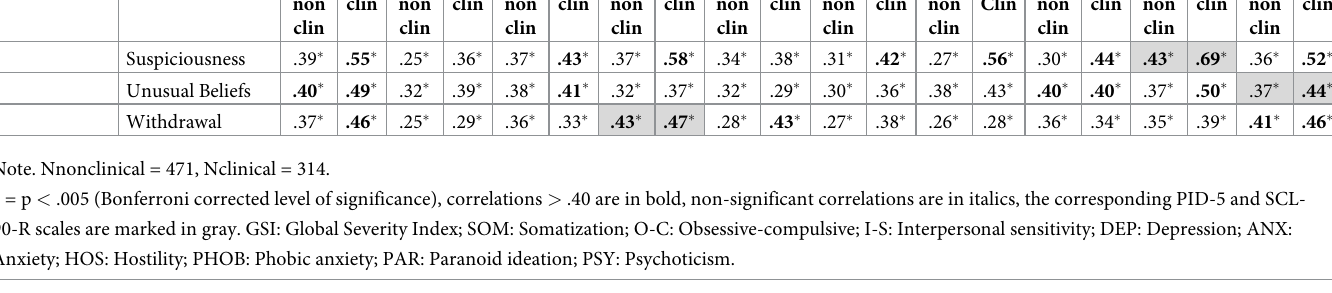
tion. Associations between PID-5 domains and facets comparing clinical and non-clinical groups, gender differences, as well as correlations with age and education are reported in Table 8. 3 . 2 . 2 . 1 . Clinical and non-clinical differences . MANOVA was run to analyze clinical and non-clinical differences along with the 25 personality disorder traits and the 5 domains. Based on the 25 traits we found significant differences with a large effect size (Wilks’s l = .449; F (25, 759) = 37.31; p < .001; h 2 = .551). More specifically, the Manipulativness, Deceitfulness and Risk Taking traits did not show significant differences between the clinical and non-clinical groups; for all the other traits, scores were significantly higher in the clinical group. At the domain level, the difference was also significant with a large effect size (Wilks’s l = .564; F (25, 779) = 120.606; p < .001; h 2 = .436). 3 . 2 . 2 . 2 . Gender differences . According to our results, the male and female profiles of person- ality disorder traits were significantly different and the difference had a large effect size in both the clinical (Wilks’s l = .755; F (25, 288) = 3.735; p < .001; h 2 = .245) and the non-clinical